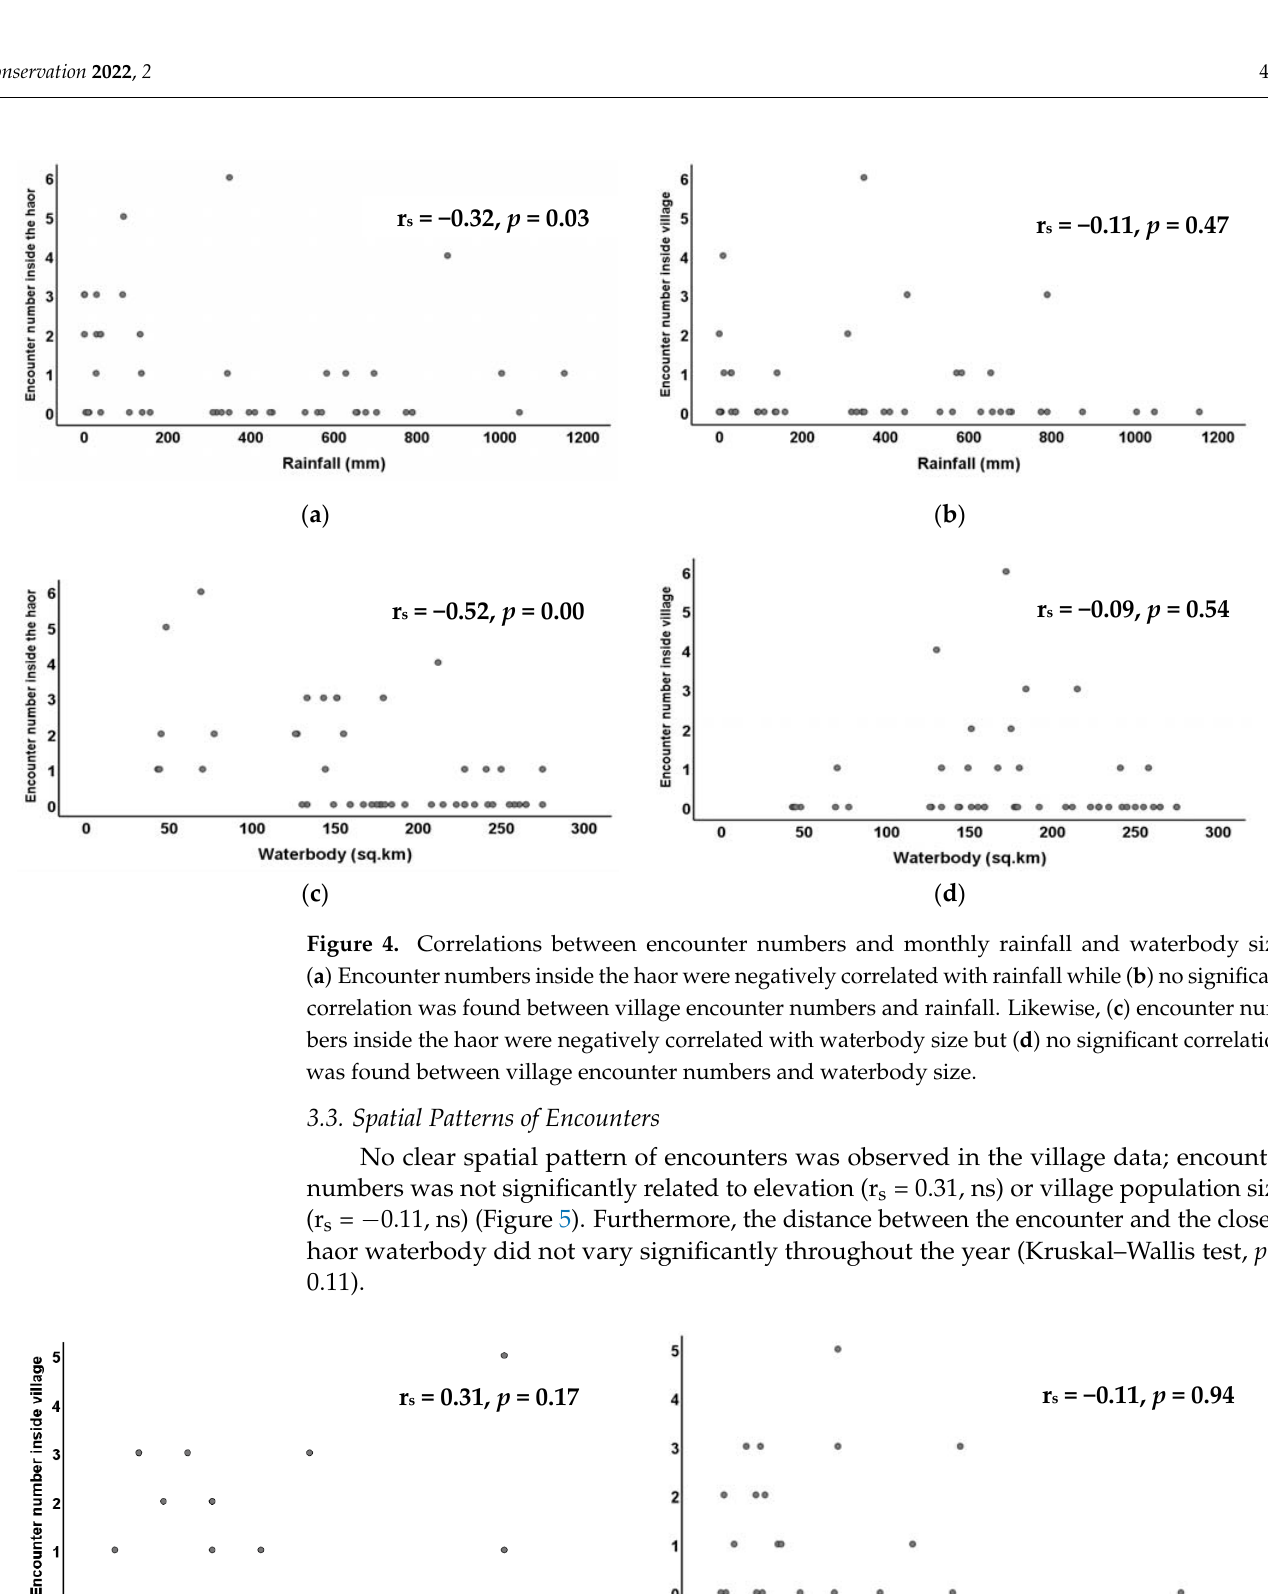
Figure 3. Changes in monthly rainfall and waterbody size within Hakaluki Haor.